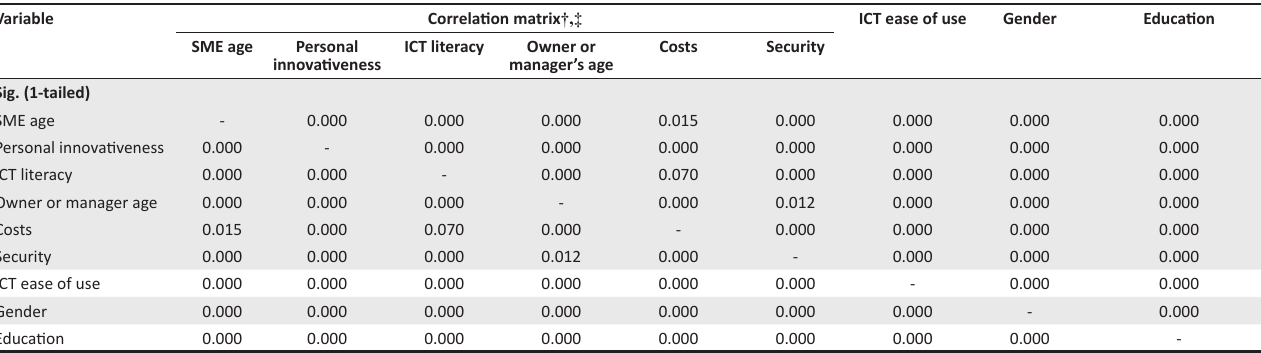
TABLE 4: Correlation matrix.